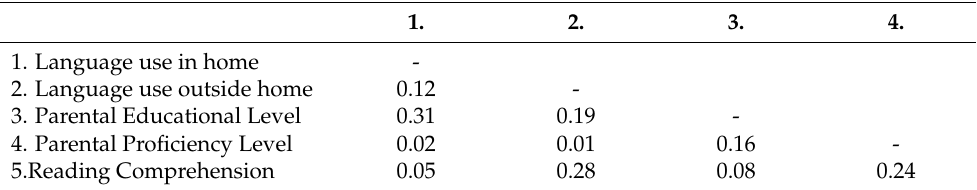
Table 8. Correlation matrix for children’s performance on reading comprehension and language use in and outside home, parents’ self-rated language proficiency and parents’ educational level in